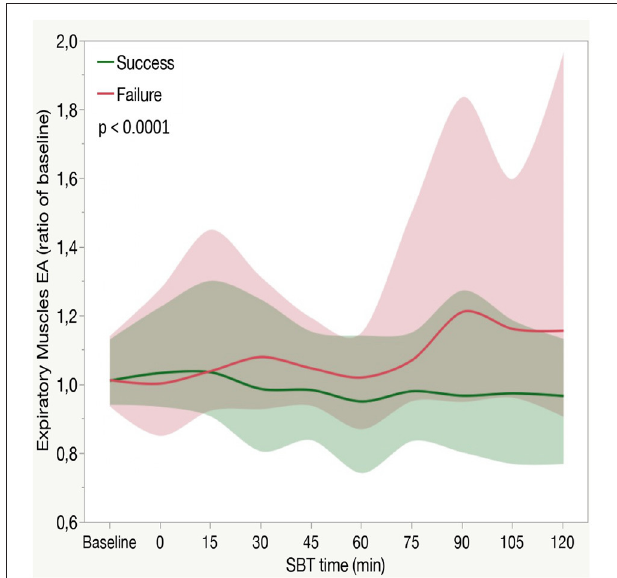
FIGURE 3 | Expiratory muscles electrical activity (EXP surf ) in patients who fail or succeed weaning attempt along with aSBT. Each line indicates the median value with bands indicating IQR. The P -value expressed in the figure is for the between-group comparison performed with the use of the two-factor analysis of variance to test time (from baseline to 120min of SBT) and group effects (SBT failure or success). In a posthoc analysis median EXP surf at each time point (from 0 to 120min) was not different than baseline ( p > 0.05) in the success group, while it was higher than baseline in the failure group from 75 to 120min ( p < 0.0001). At each time point, EXP surf was higher in the failure group compared with the success group from 75 to 120min ( p <